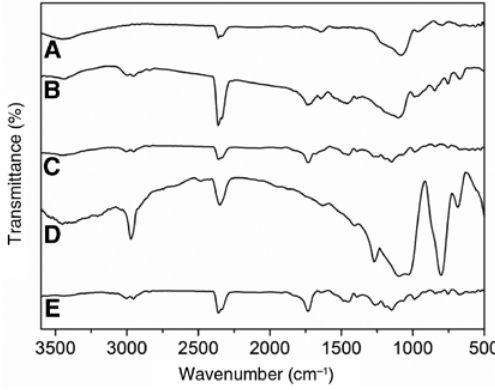
Figure 4: Fourier transform infrared (FTIR) spectra of (A) silica aerogel (SA), (B) poly(methyl methacrylate) (PMMA), (C) SA/PMMA, (D) SA/amino-capped polydivinylsiloxane (AP) and (E)